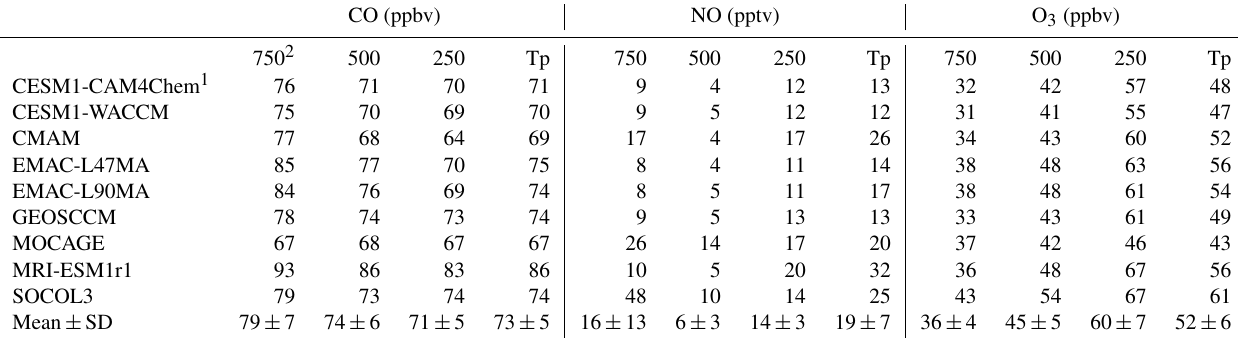
Table 5. Global volume-weighted mean CO, NO, and O 3 mixing ratios averaged over the whole troposphere and three pressure altitude levels for CCMI models from 2000 to 2010. Multi-model means and standard deviations (mean ± SD) are also shown. CO